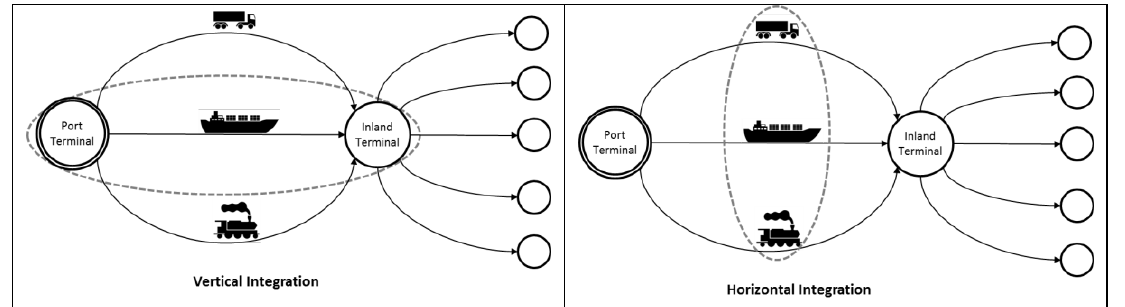
Figure 1. Integrated view of freight transport planning